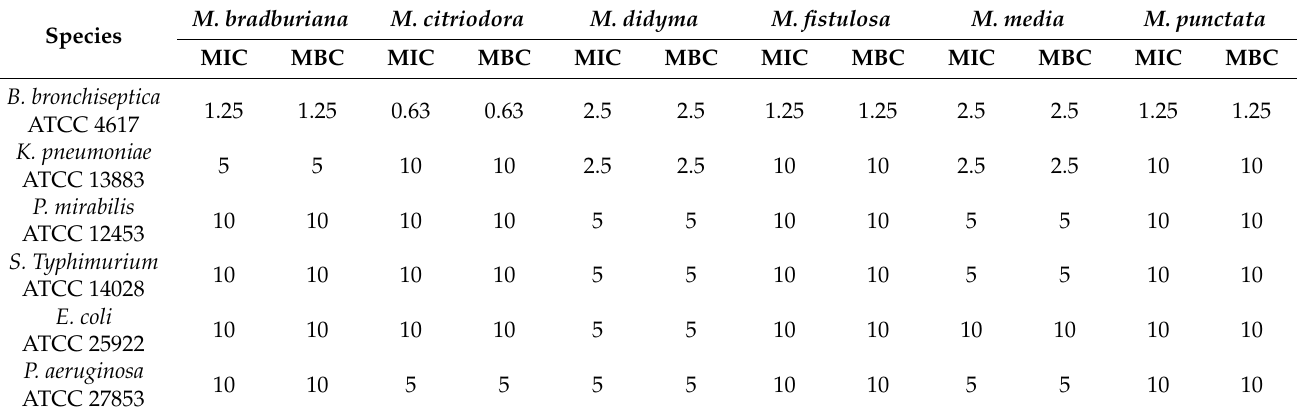
Table 4. Antimicrobial activity in vitro of 70% ( v/v ) methanolic extracts of Monarda species expressed as MIC and MBC (mg/mL) values against the reference strains of Gram-negative bacteria. The representative values (mode) are